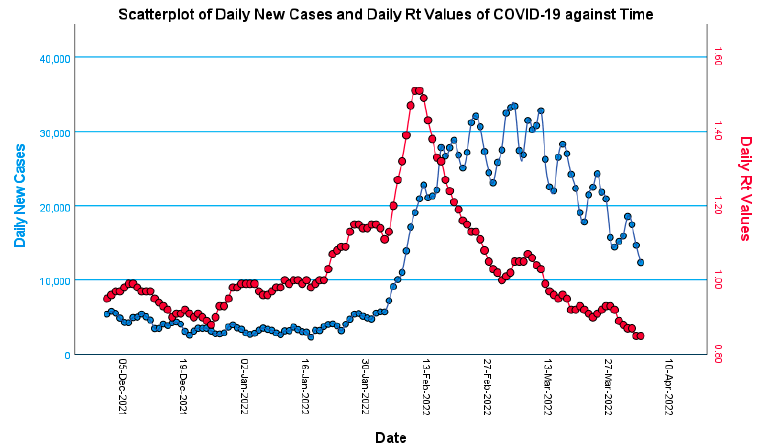
Figure 1. Scatter plot of daily Rt values (red line) and daily new cases of COVID-19 (blue line) in Malaysia against time, from 1 January 2022 to 31 March 2022. Raw data were sourced from GitHub repository by Ministry of Health Malaysia [13].